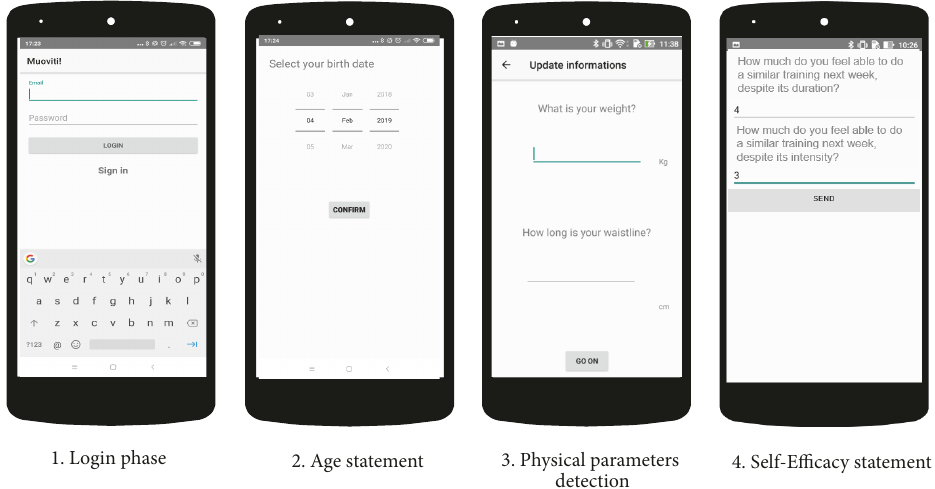
Figure 2: Screenshots from the Graphical User Interface (GUI) of the Muoviti!